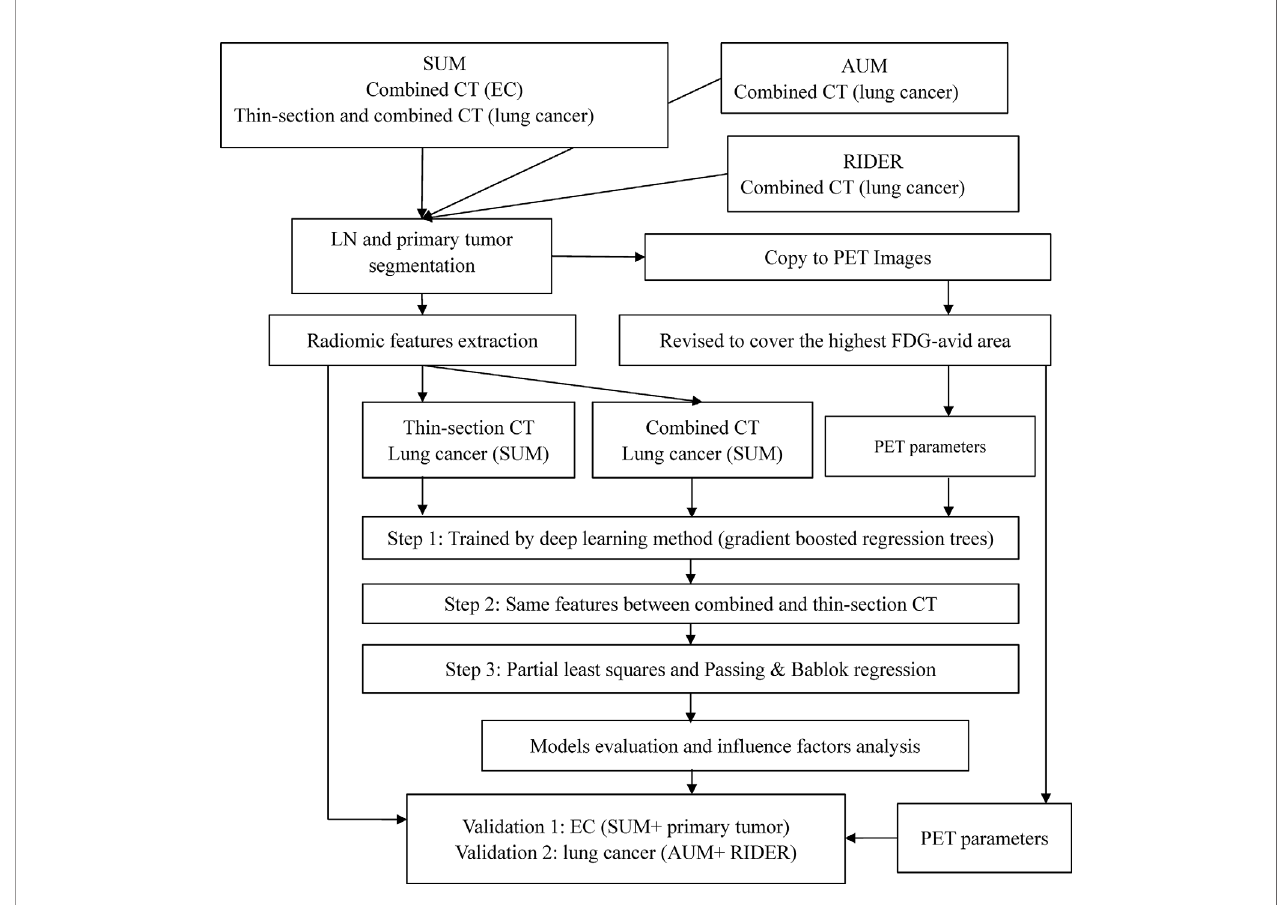
FIGURE 1 | Study design and variable selection